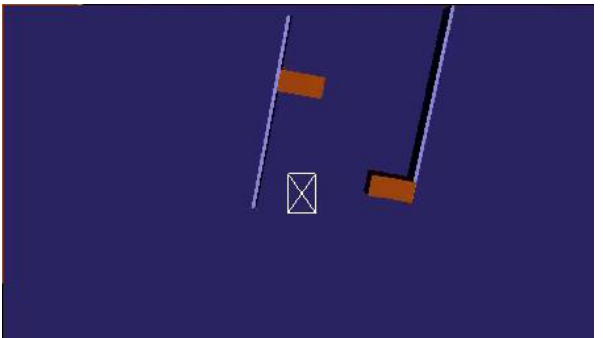
Figure 3. Example of a top view of the virtual reconstruction of a real scene with a vehicle navigating through a corridor. The virtual reconstruction is a totally virtual view of the real scene generated automatically using the information obtained by the multimarker configuration. The vehicle is represented by a white crossed box. The virtual corridor walls and obstacles are also displayed in the view. The vehicle is always displayed in the centre of the view in a similar disposition as in traditional GPS systems. The virtual reconstruction is constantly updated with the position of the vehicle respect to the corridor and obstacles obtained by the multimarker detection